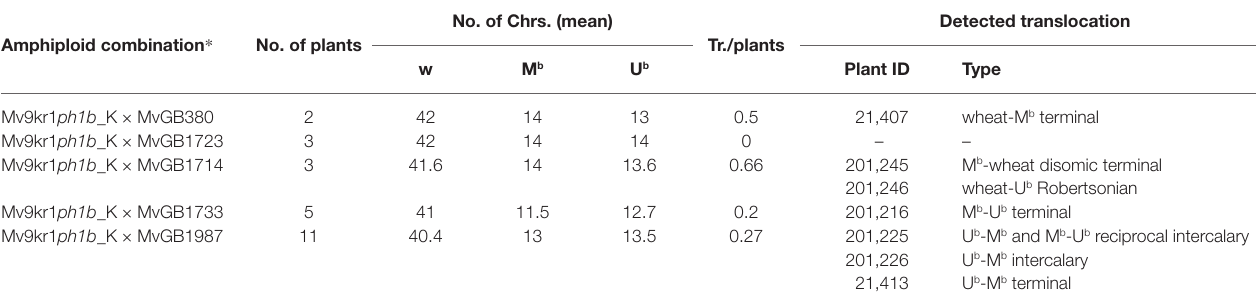
TABLE 6 | Genomic constitution of Mv9kr1 ph1b_ K × Aegilops biuncialis amphiploids. Amphiploid combination * No. of plants